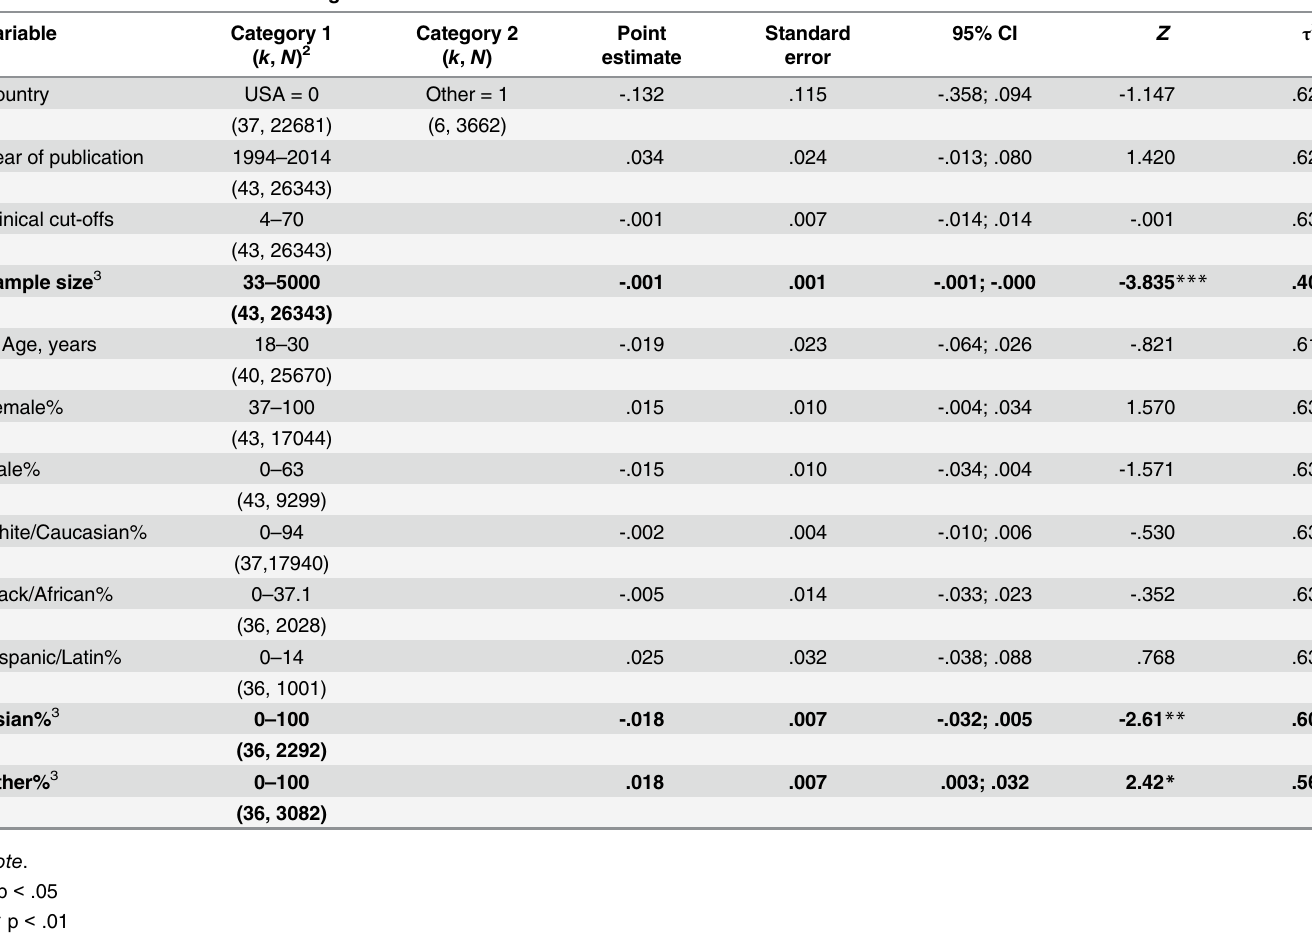
Table 2. Results of univariate meta-regression 1